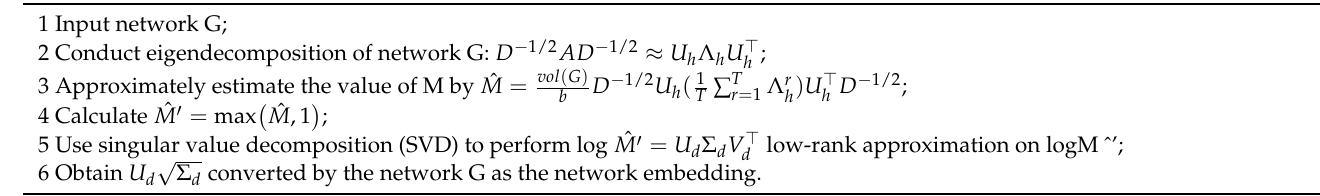
Table 2. The processing steps of community discovery.